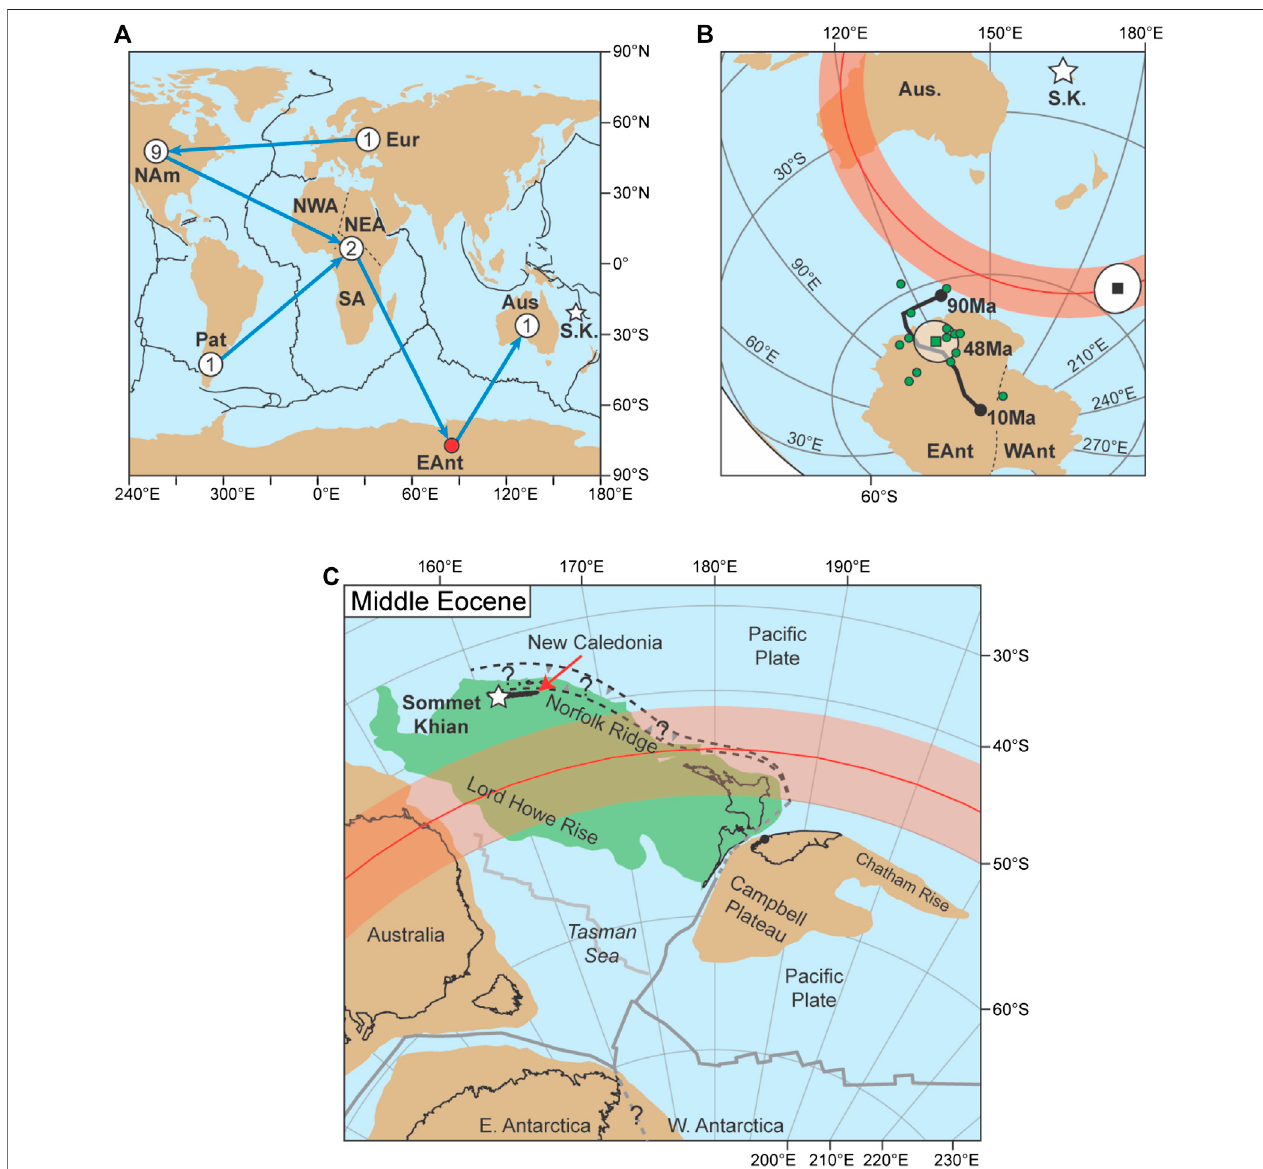
FIGURE7| Geologicalandpaleomagnetic-paleogeographicframeworkoftheSommet-KhianrecordfromnorthernNewCaledonia;inallpanels:Aus (cid:1) Australia;Eur (cid:1) stable Europe; EAnt and WAnt (cid:1) east and west Antarctica; NAm (cid:1) north America; NWA, NEA, and SA (cid:1) northwest, northeast, and south Africa; Pat (cid:1) Patagonia; S.K. (cid:1) Sommet-Khian. (A) Globalplate con fi guration and circuits(blue arrows) connecting the Australianplate withthe source ofthe paleomagnetic data for the 53 – 43 Ma interval includedinthereferencecompilationofTorsviketal.(2012);( SupplementaryTableS3 );whitecircleindicatethesourceplateofthedataandthenumberofentries. (B) The average paleomagnetic pole from Sommet-Khian (black square with white 95% con fi dence cone) is compared with the reference paleomagnetic pole (green square) calculated averaging 14 entries (green dots) from the compilation of Torsvik et al. (2012) that fall within the 53 – 43 Ma window ( Supplementary Table S3 ); the 90 – 10 Ma globalsynthetic apparent polar wander pathfromthe samecompilation, plotted inAustraliancoordinates, isalsoshown asthick black line;the redlinewiththeshadedarea showsthat,evenrotatingtheS.K.poletotowardreference48 Maone,theyremainstatisticallydistinguishable. (C) PaleogeographicreconstructionoftheSouthwestPaci fi c area in the middle Eocene ( ∼ 45 Ma); continental areas are fi lled in light brown except for northern Zealandia (light green); the light gray line is the Tasman Ocean spreading ridge,whichactivityendedduringChron24n( ∼ 53 Ma),andthedarkgraylinesareactivespreadingridges;dottedblacklinesaretheapproximatepositionoftheproto-Tonga- Kermadecsubduction zoneand the north-east dipping earlyEocene east-dippingsubduction zoneinferredbythe geology ofNew Caledonia (see text); the white staristhe location of Sommet-Khian. While the reconstruction is based on the published reference data, the red line with the red shaded area is the paleolatitude and associated con fi dence boundaries obtained from the paleomagnetic directions from Sommet-Khian.